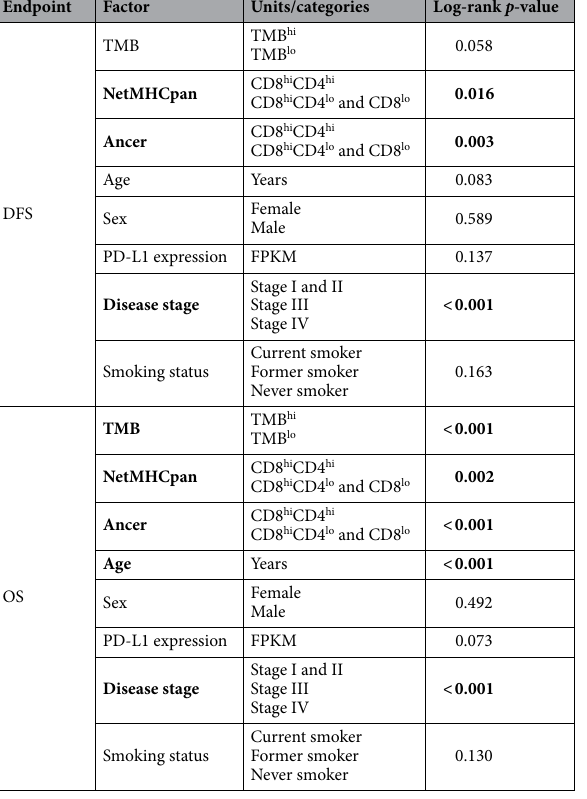
Table 2. Exploration of other factors associated with survival. Each factor was analyzed in a univariate survival analysis to determine its significance with disease free (DFS) or overall survival (OS). Significant factors and log-rank p-values are